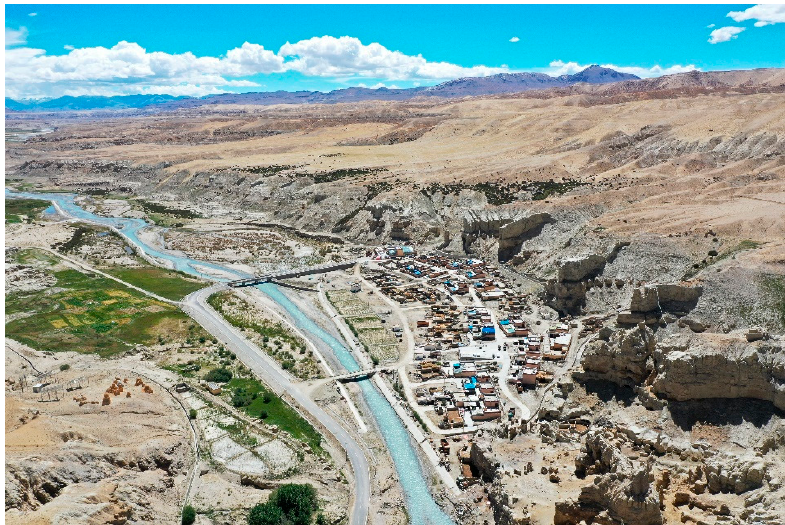
Figure 3. Aerial view of Rebujialin (self-photographed).